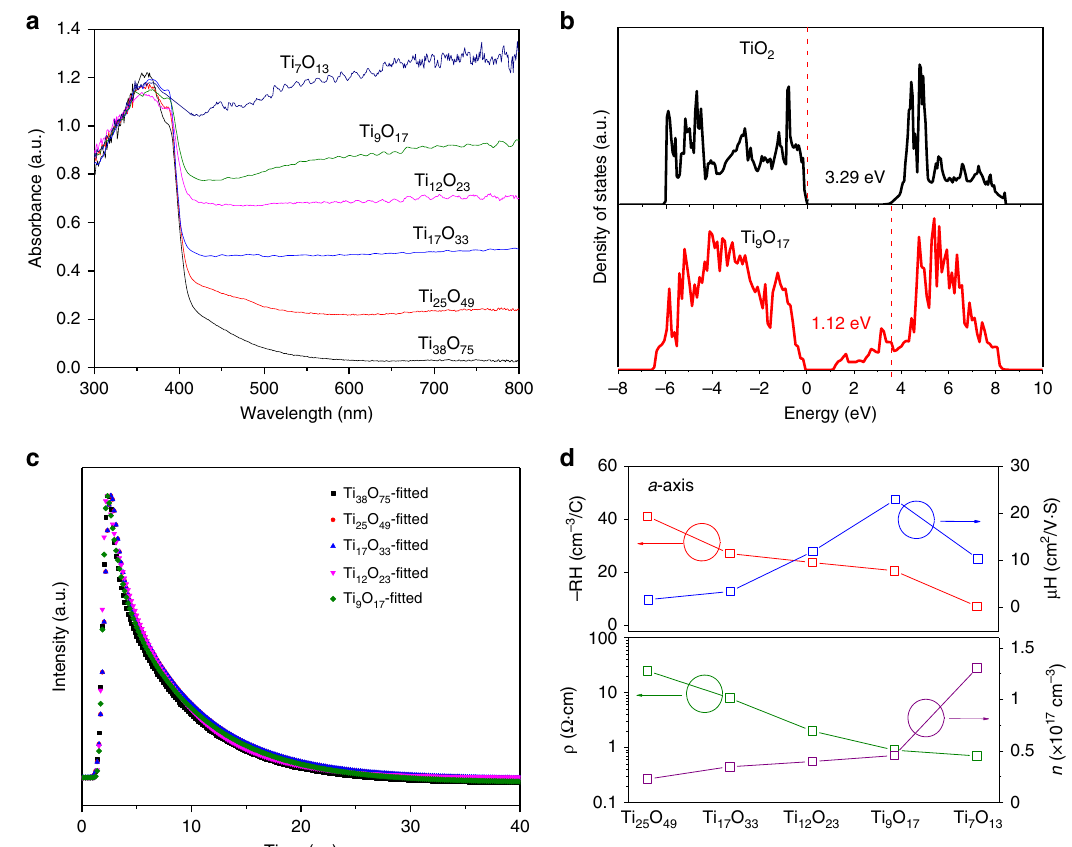
Fig. 5 Physical properties of the porous single-crystalline (P-SC) Ti n O 2 n − 1 . a Ultraviolet-visible diffuse re fl ectance spectra of Ti n O 2n-1 single crystals with different n values. b Density of states for TiO 2 and Ti 9 O 17 magneli phase with Ti 3 + interstitials. The Fermi levels are shown as vertical lines. c Decay pro fi les of transient absorption of the P-SC Ti n O 2 n − 1 crystals. d The resistivity, carrier density, Hall coef fi cient and Hall mobility of Ti n O 2 n − 1 single crystals grown along the a -axis of KTP crystal